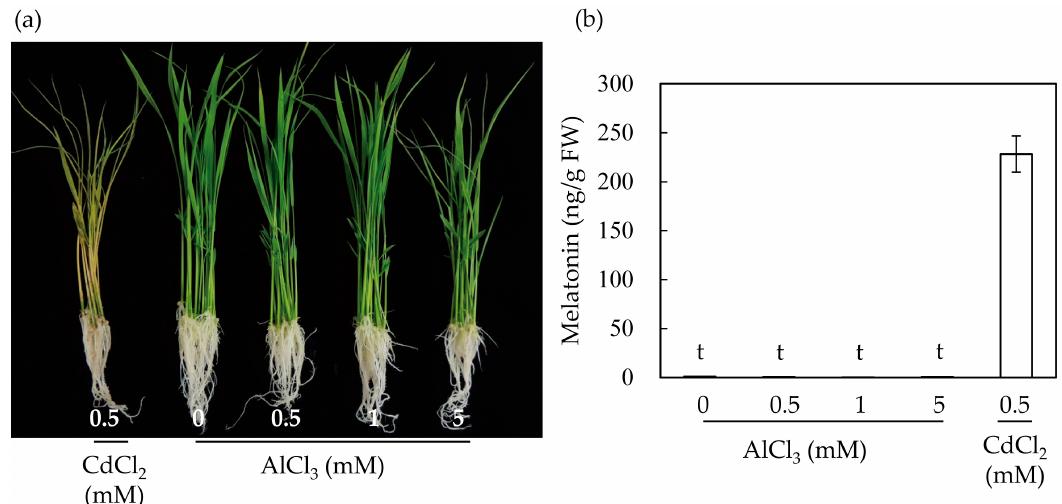
Figure 2. Induction of melatonin in response to cadmium and aluminum treatments in seven-day-old rice seedlings. ( a ) Phenotypes of rice seedlings upon cadmium and aluminum treatments; ( b ) Quantification of melatonin by HPLC. Data represent mean ± standard error of the mean, n = 3. Rice seedlings grown for seven days were challenged with cadmium (0.5 mM) or aluminum of varying concentrations for three days under continuous light. FW, fresh weight; t denotes 1 ng/g FW.